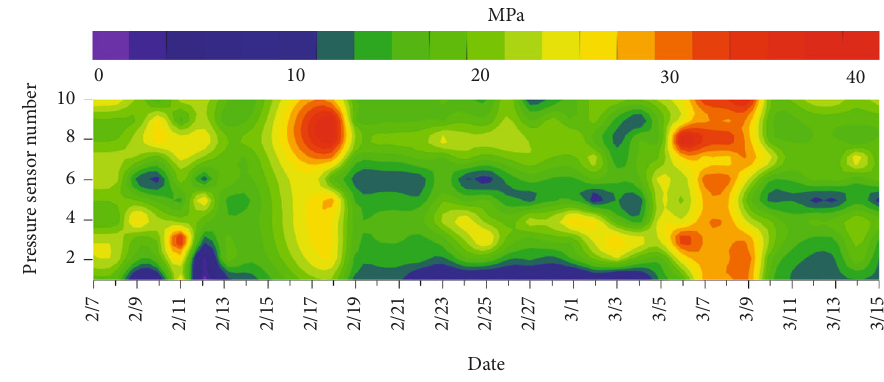
Figure 15: Support pressure